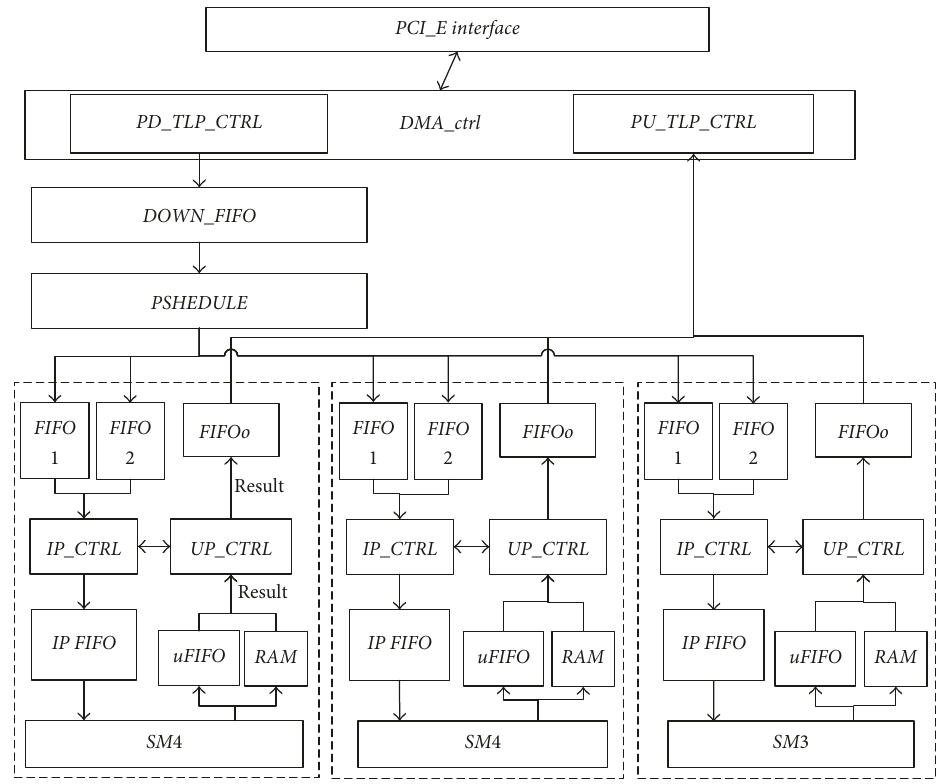
Figure 11: Hardware architecture of partem.